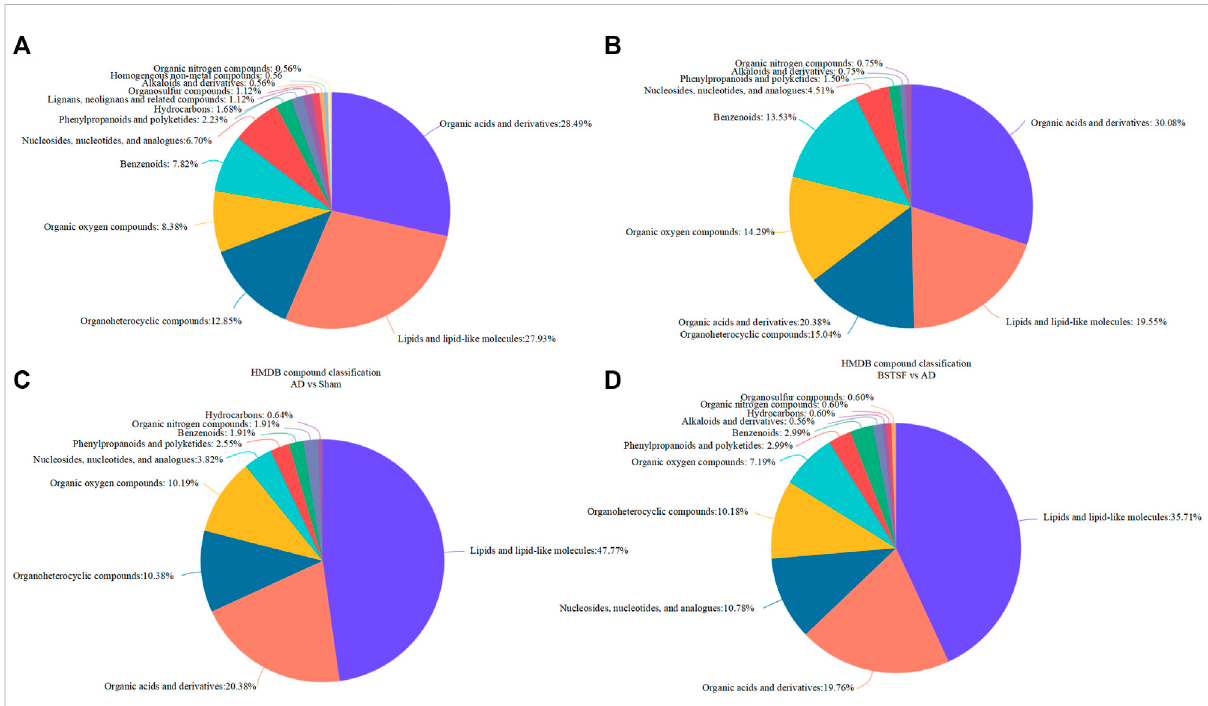
FIGURE 4 HMDB database classi fi cation. (A,C) : differential metabolites in the HMDB database classi fi cation between the AD and sham groups; (B,D) : differential metabolites in the HMDB database classi fi cation between the BSTSF and AD